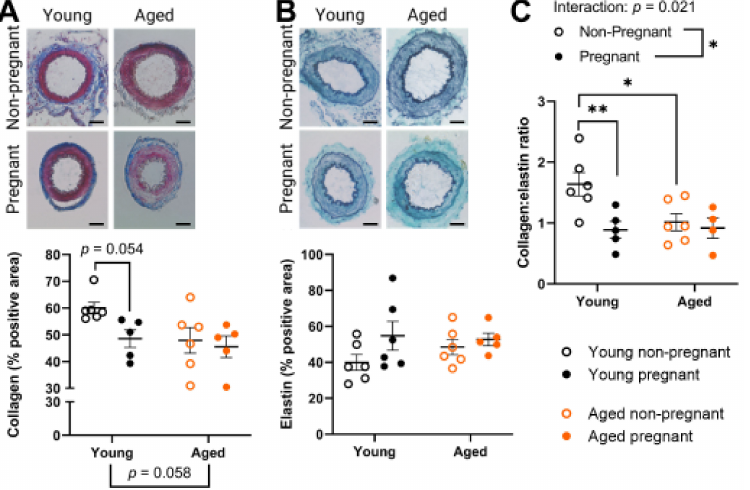
Figure 4. Structure of main uterine arteries from young and aged nonpregnant and pregnant (GD 20) rats. Tunica intima and media (combined) percentage positive area for ( A ) collagen (Masson’s Trichrome; collagen is stained blue) and ( B ) elastin (Verhoff stain with Fast Green counterstain; elastin fibers are stained dark), and the ( C ) collagen:elastin ratio. Scale bar represents 100 µ m. Data presented as mean ± SEM; n = 4–6/group. Outcomes were compared using a two-way ANOVA (age vs. pregnancy status) followed by Sidak’s post hoc test. * p < 0.05; ** p < 0.01.